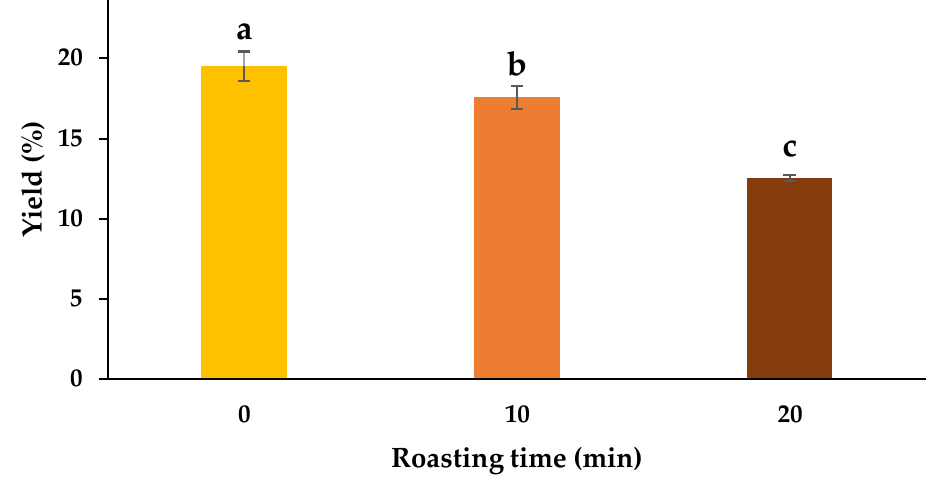
Figure 1. Extraction yield (%) of 0 min, 10 min, and 20 min roasted seeds of butterfly pea.